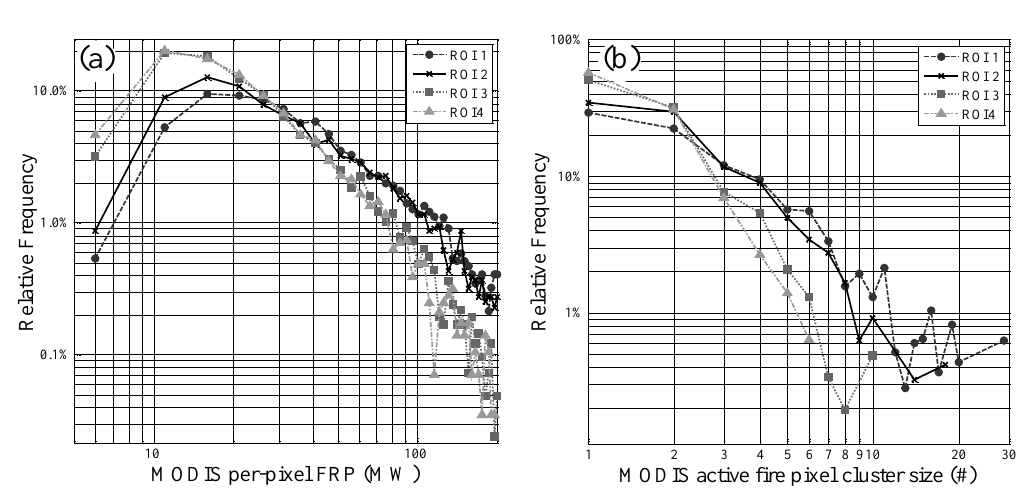
Figure 8. ( a ) Histogram of the per-pixel fire radiative power (FRP) measured by MODIS in each of the four ROIs depicted in Figure 1a between 1 October 2008 and 31 April 2009. A shift in the distributions from high FRP pixels to low FRP pixels between ROI 1 and ROI 4 is coherent with an increase in SEVIRI’s omission rate. ( b ) Histogram of the cluster size of MODIS active fire pixels in each of the four ROIs between 1 October 2008 and 31 April 2009. A shift in the distribution from larger to smaller cluster sizes between ROI 1 and ROI 4 is also coherent with an increase in SEVIRI’s omission